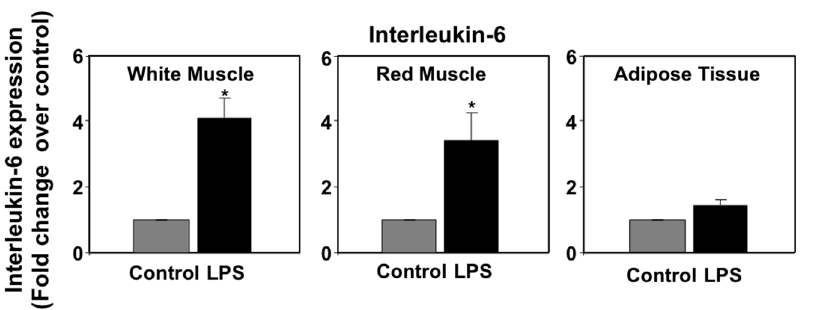
Figure 4. Effects of lipopolysaccharide (LPS) administration in vivo on interleukin-6 (IL-6) gene expression in seabream tissues. The mRNA expression levels of IL-6 were measured by qPCR in seabream tissues at 72 h after LPS administration. Results are expressed as fold induction over the control (saline-injected) group, which was set to 1, and shown as means ± SE of five fish per group, with each sample performed in triplicate. Asterisks indicate significant differences from control ( p < 0.05).